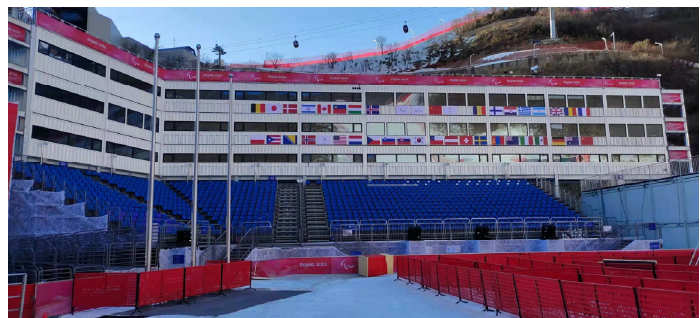
Figure 2. The grandstand and CHs of the Technical Finish Area.